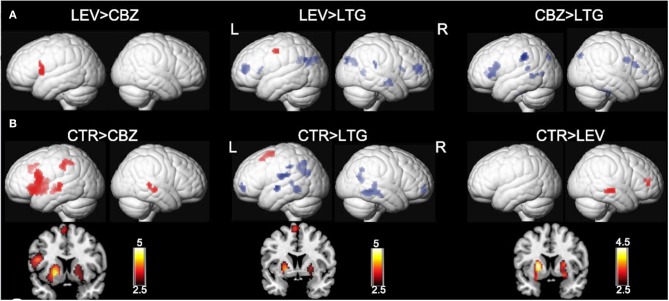
Effects of carbamazepine and lamotrigine on functional magnetic resonance imaging cognitive networks. Significant group differences between patients on carbamazepine (CBZ), levetiracetam (LEV), and lamotrigine (LTG) and healthy controls (CTR) are demonstrated on a surface-rendered brain template, and the subcortical changes are demonstrated on a coronal brain template with a bar chart indicating z score. (A) Patients on CBZ activated less in the left inferior frontal gyrus than patients on LEV. In patients on LTG, deactivation was reduced in the task-negative areas, including the middle frontal gyri and left dorsal parietal region of the precuneus, compared with patients on LEV and CBZ. P < 0.005, 10-voxel threshold. (B) All three groups of patients activated the putamen less bilaterally (left > right) than CTR. Patients on CBZ activated the left inferior frontal gyrus less than CTR. There was less deactivation in the bilateral medial frontal gyri and bilateral lateral temporal regions, left rolandic operculum, and left inferior parietal lobule in patients on LTG. P < 0.005, 10-voxel threshold. L, left; R, right. Reproduced with permission from Xiao et al. (20).